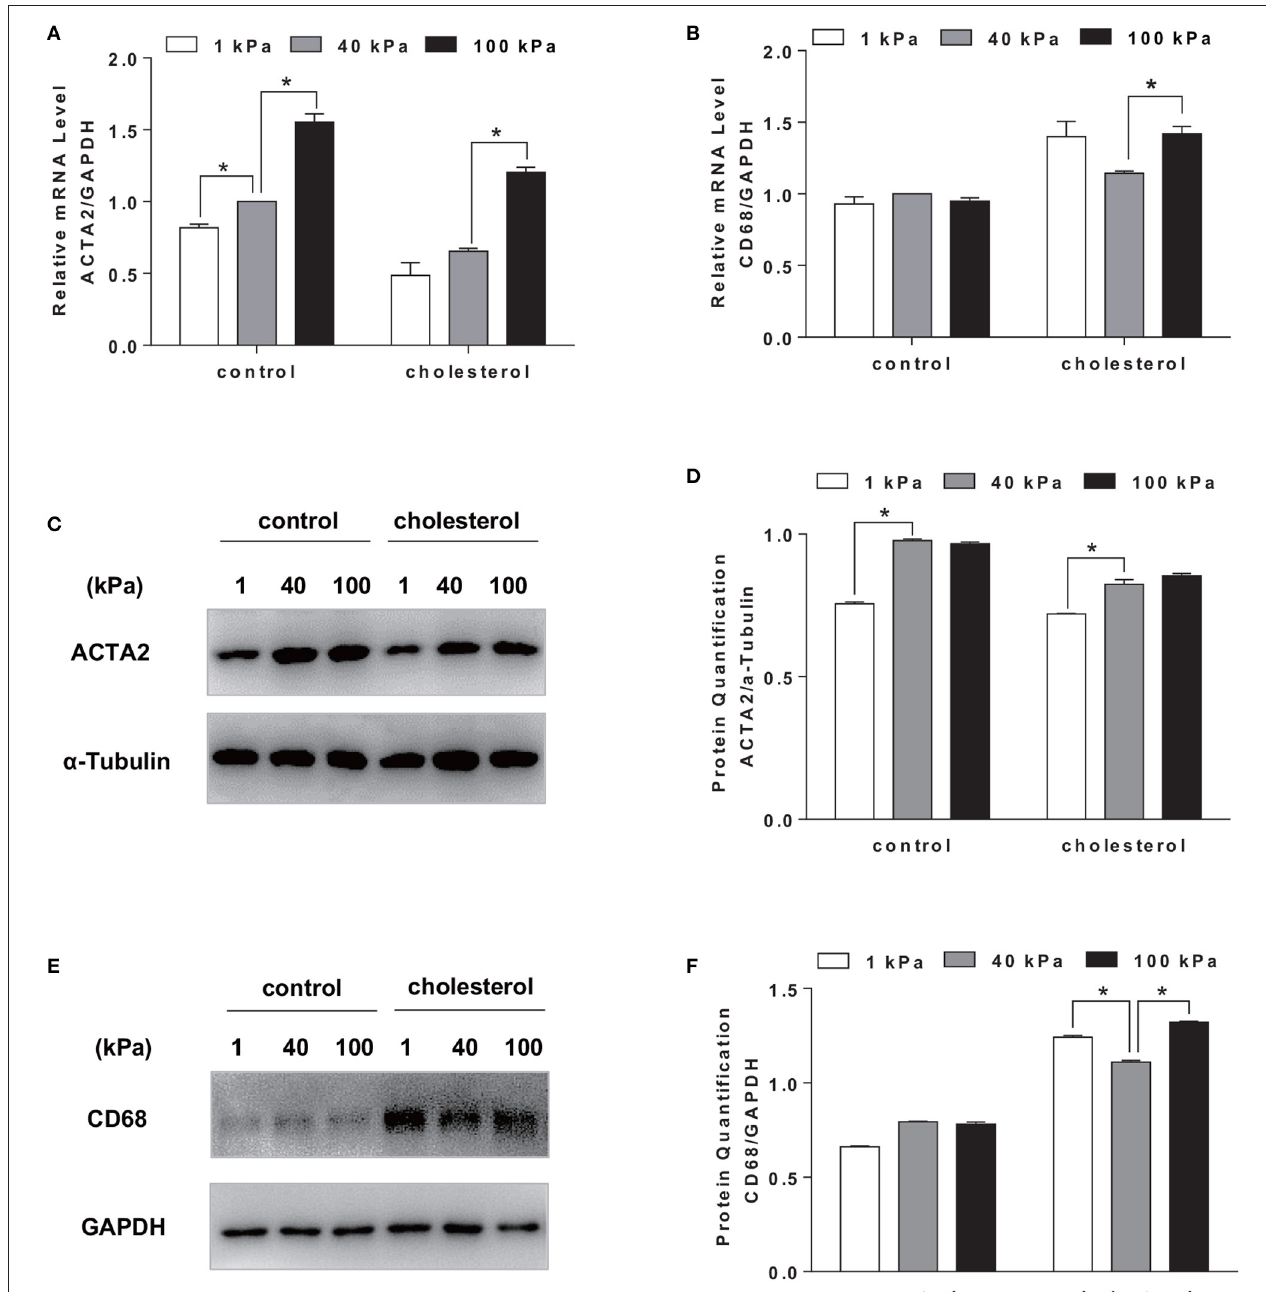
FIGURE 3 | Substrate stiffness affected SMCs phenotypic transformation. SMCs were seeded on substrate with different stiffness and treated with 20 µ g/ml Chol: M β CD for 72 h. SMCs without treatment were used as control. (A,B) ACTA2 and CD68 gene expression level was measured by RT-qPCR. GAPDH was used as the internal control for normalization ( n = 3). (C,D) ACTA2 protein expression was analyzed by Western blotting analysis. The expression of α -Tubulin was used as the internal control. Quantitation of the protein expression was calculated as the ratio of target protein to α -Tubulin ( n = 3). (E,F) CD68 protein expression was analyzed by Western blotting analysis. The expression of GAPDH was used as the internal control. Quantitation of the protein expression was calculated as the ratio of target protein to GAPDH ( n = 3). ∗ p < 0.05.